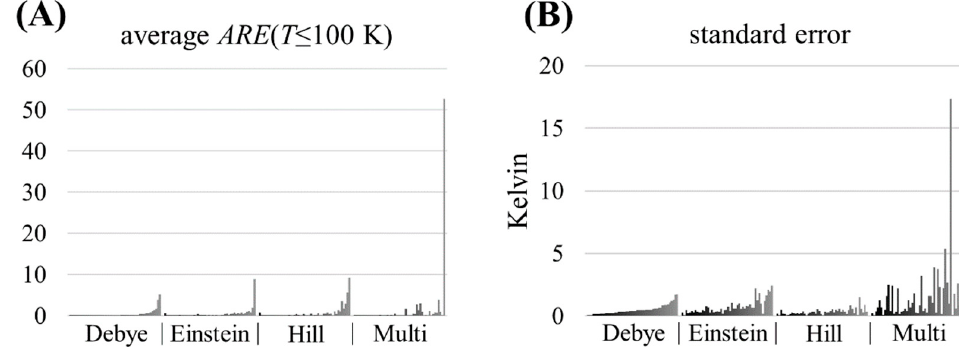
Figure 5. Evaluation metrics of specific the heat models. Each vertical bar is from data analysis on a single covalent solid from the 53 compounds that were fit to specific heat expressions. The results of Debye Model fits to all 53 solids are shown leftmost in each graph, whereas the Multilinear Model (Multi) fits to all 53 solids are shown rightmost in each graph, with Einstein and Hill Equation fits nested left and nested right within each graph. ( A ) Average absolute relative error (AARE) of each model fit to each solid for data from temperatures below 100 Kelvin, unitless. Low AARE reflects a better model fit. ( B ) Standard error in J/(mole ⋅ Kelvin) of each model fit to each solid across all available temperature data. Low standard error reflects a better model fit. ( C ) Average absolute relative error (AARE) of each model fit to each solid for data from temperatures above 100 Kelvin, unitless. Low AARE reflects a better model fit. ( D ) Correlation coefficient of each model fit to each solid. Unity correlation reflects a better model fit. Prior work has shown a correlation between the Hill coefficient and Gibbs free energy of interaction in noncovalent binding [23]. Under Richard’s Rule, the standard enthalpy of fusion underpins Gibb’s free energy in covalent solid binding [18]. A correlation between the enthalpy of fusion and the Hill Coefficient could imply a fundamental basis for use of the Hill Equation in solid specific heat estimation. To explore this possibility, the discovered Hill Coefficients were plotted against the enthalpy of fusion for alkaline metals and alkaline halides. Figure 6 shows the results. A linear trend was observed within the alkaline metals and alkaline halide groups on the periodic table, although not across alkaline metals and alkaline halides generally. 4. Discussion The Hill Equation was fit to experimental heat capacity data for 53 inorganic compounds and technical solids. At common chemical process temperatures (>100 K [46]), the Hill Equation predicted specific heat capacity more accurately than the Debye Model, the Einstein Solid, and the Multilinear Model. At lower temperatures the Debye Model proved superior. However, the Debye Model requires the evaluation of a numerical integral, which can slow process simulation. Table 1 shows that use of the Debye Model